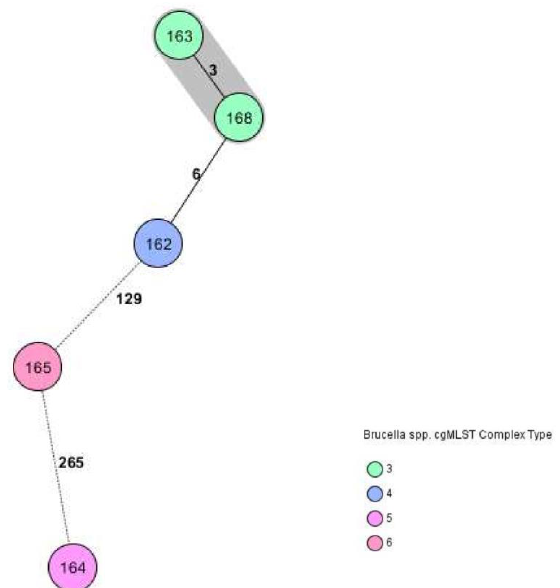
Figure 3. Ridom SeqSphere+ minimum spanning tree of the five Bavarian Brucella suis biovar 2 genomes from wild boars based on 1764 alleles. Two isolates from the same year are closely related (shaded in grey). The cluster distance threshold was 3.